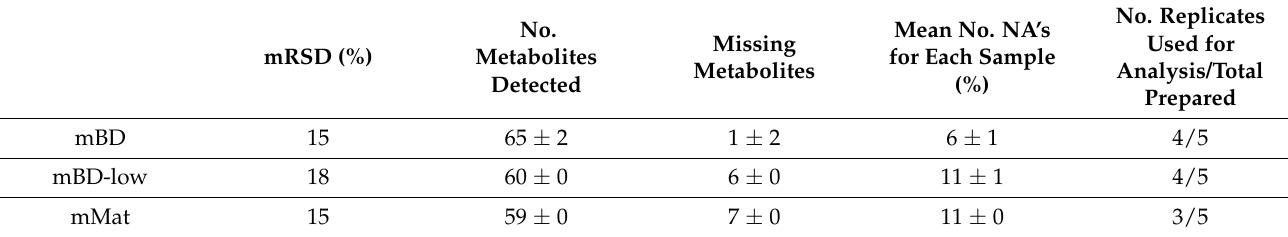
Table 3. Summary of the number of metabolites detected and missing from the mouse bone after performing extraction. The metabolites were extracted with the modified Bligh–Dyer (mBD), mBD with low chloroform (mBD-low), or modified Matyash (mMat) method. mRSD: median relative standard deviation in %, NA: no value available.